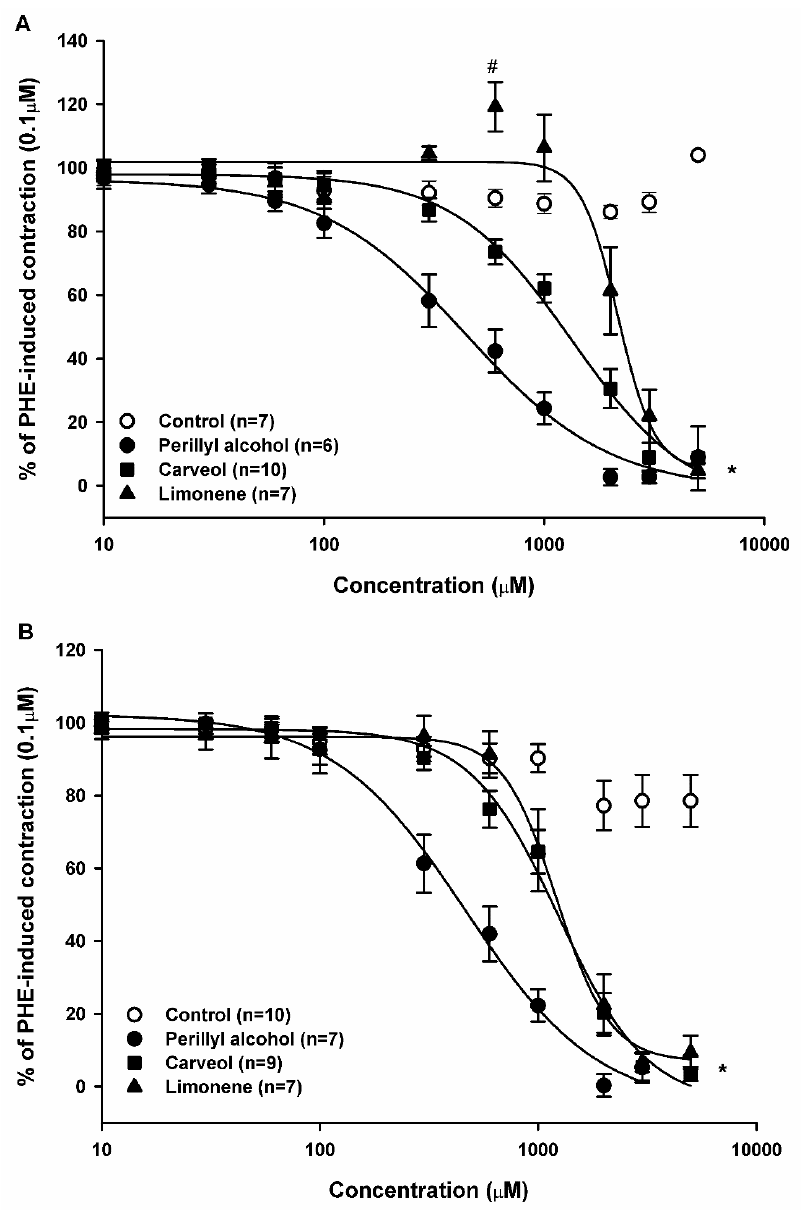
Figure 4. Relaxant effect of limonene, carveol, and perillyl alcohol on pharmacomechanical coupling. Sustained contractions induced by PHE (0.1 μM) in endothelium-intact ( A ) and endothelium-denuded ( B ) rat aortic rings. Results are shown as means ± SEM. * indicates statistical difference of limonene, carveol, and perillyl alcohol compared to the control ( p < 0.05, two way ANOVA and Holm-Sidak test). # indicates statistical difference between limonene (600 μM) compared to the control ( p < 0.05, one-way ANOVA and Holm-Sidak test). Each control consisted of the same concentration of vehicle as in the experimental case, but without the experimental substance.